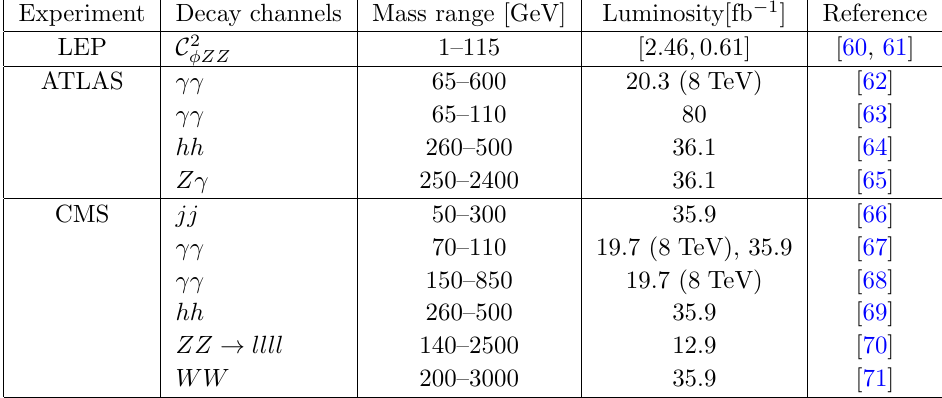
Table 2 . This table collects all the relevant analyses used in our phenomenological study of a light dilaton with their respective mass range and luminosity, including LEP, ATLAS and CMS results. The ATLAS and CMS results are mainly from the LHC run-2 with the center of mass energy 13 TeV, whereas the ones from 8 TeV are